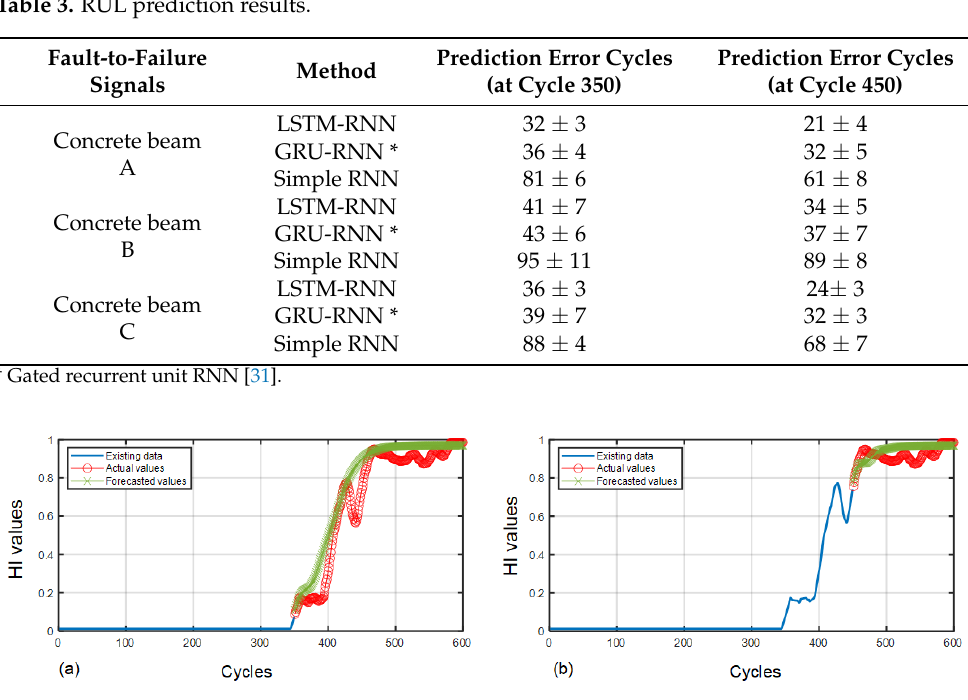
Figure 15. LSTM-RNN-based RLU prediction results of concrete beam B: ( a ) at cycle 350; ( b ) at cycle 450. In Figure 16, specimen C ’ s prediction results from the proposed method are plotted; its values can be again checked in Table 3. The first prediction at cycle 350 shows the pre- diction error for our proposed method and the GRU-RNN as 36 and 39 cycles, respec- tively; the prediction error at cycle 450 are 24 cycles with LSTM-RNN and 32 cycles with GRU-RNN. Concerning the simple RNN, the 88 and 68 divergent cycles in the two pre- dictions clearly demonstrate its failure of long-term dependencies learning. Figure 16. LSTM-RNN-based RLU prediction results of concrete beam C: ( a ) at cycle 350; ( b ) at cycle 450. 5. Conclusions Reliable HI curves construction and long-term dependencies learning of degradation data are important but challenging tasks for an accurate remaining useful life (RUL) esti- mation of concrete structures. In this study, we proposed an SAE-DNN model that auto- matically constructs HI curves from degradation raw signals. The HI curves constructed have better fitness metrics than statistical parameters-based HI curves. More specifically, these HI curves have the average monotonicity and trendability metrics of 0.67 and 0.68, respectively, which much higher than those of HI curves based on statistical parameters